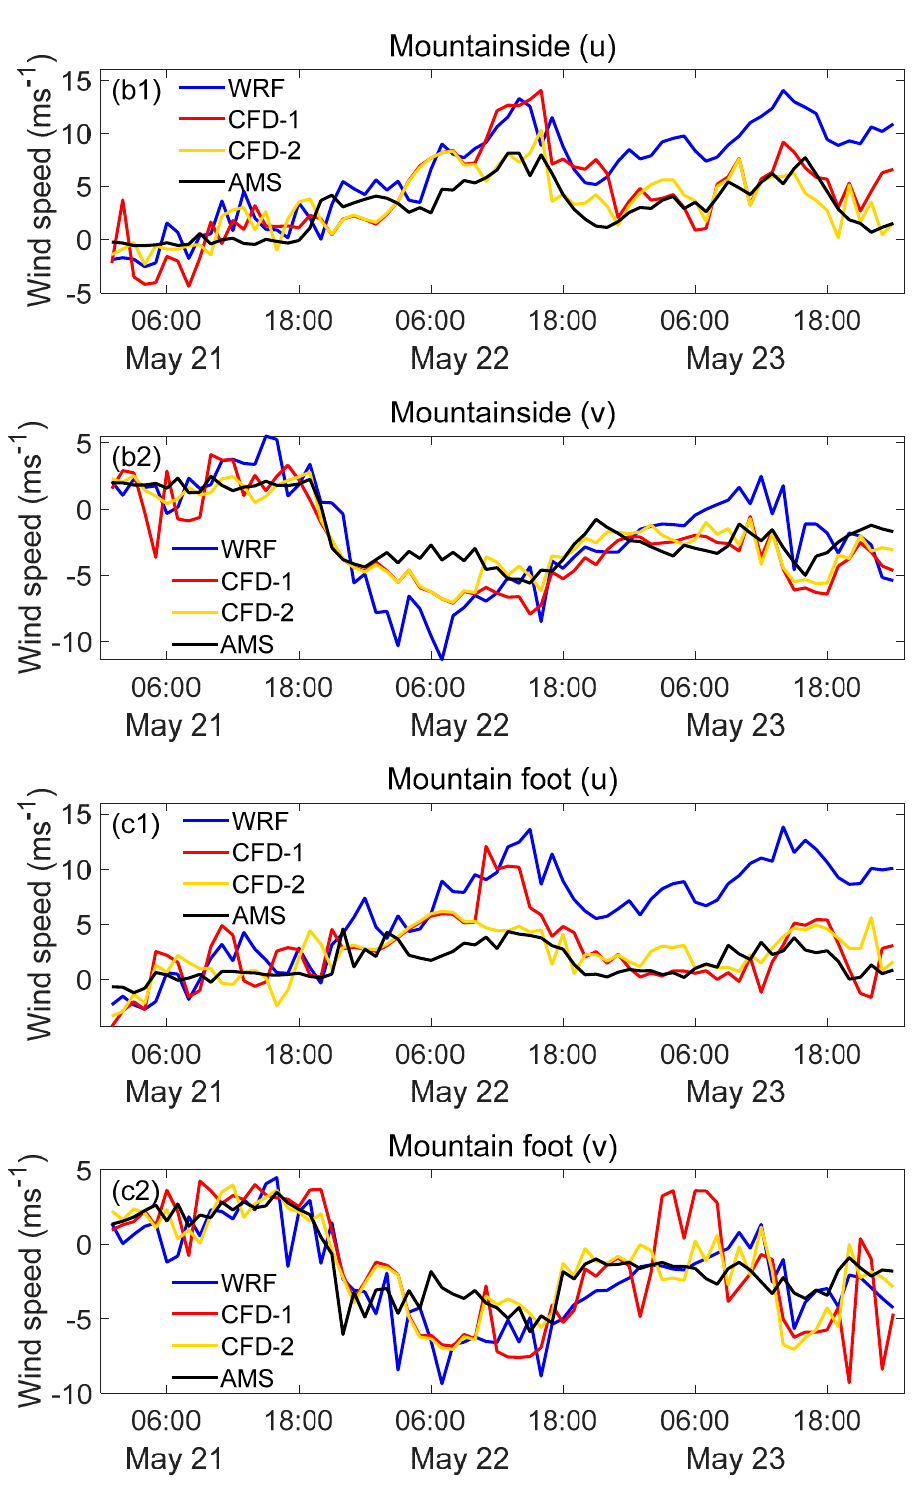
Figure 6. Time series of simulated wind for different numerical models: WRF, CFD-1, and CFD-2: ( a1 , a2 ) wind flow on the mountaintop; ( b1 , b2 ) wind flow on the mountainside; ( c1 , c2 ) wind flow at the mountain foot.